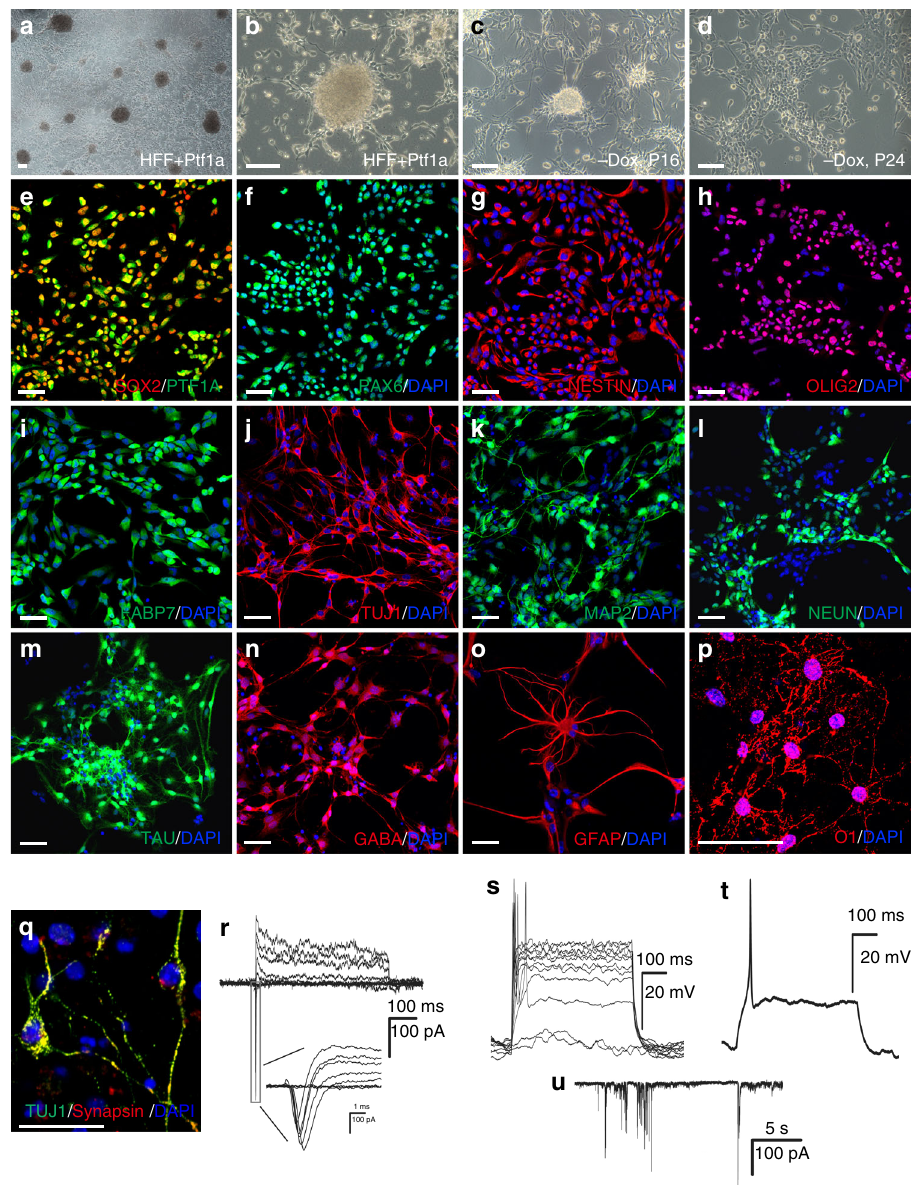
Fig. 9 Ptf1a reprograms human foreskin fi broblasts (HFF) into tripotent iNSCs. a , b Ectopic expression of Ptf1a in HFFs by lentiviruses induced the formation of neurospheres. c , d In the absence of doxycycline (Dox), Ptf1a-induced neurosphere cells were capable of forming neurospheres before passage 20 ( c ), but lost the capacity after passage 20 and became monolayered ( d ). e – i Ptf1a-induced human neural stem cells (hiNSCs) were highly immunoreactive for PTF1A, SOX2, PAX6, NESTIN, OLIG2, and FABP7. j – p Ptf1a-induced hiNSCs were capable of differentiating into neurons immunoreactive for TUJ1, MAP2, NEUN, TAU, or GABA, astrocytes labeled by GFAP, or oligodendrocytes marked by O1. q Neurons differentiated from hiNSCs were immunoreactive for both Tuj1 and synapsin. Cells in f – q were counterstained with nuclear DAPI. r Voltage-clamp recordings indicated fast activated and inactivated inward sodium currents as well as outward potassium currents on a differentiated neuron. s Current-clamp recordings revealed action potential responses of a differentiated neuron under current injection. t An action potential was induced after depolarization of the neuron. u Spontaneous postsynaptic currents recorded from a differentiated neuron. Scale bars, 80 μ m ( a – d ) and 40 μ m ( e – q